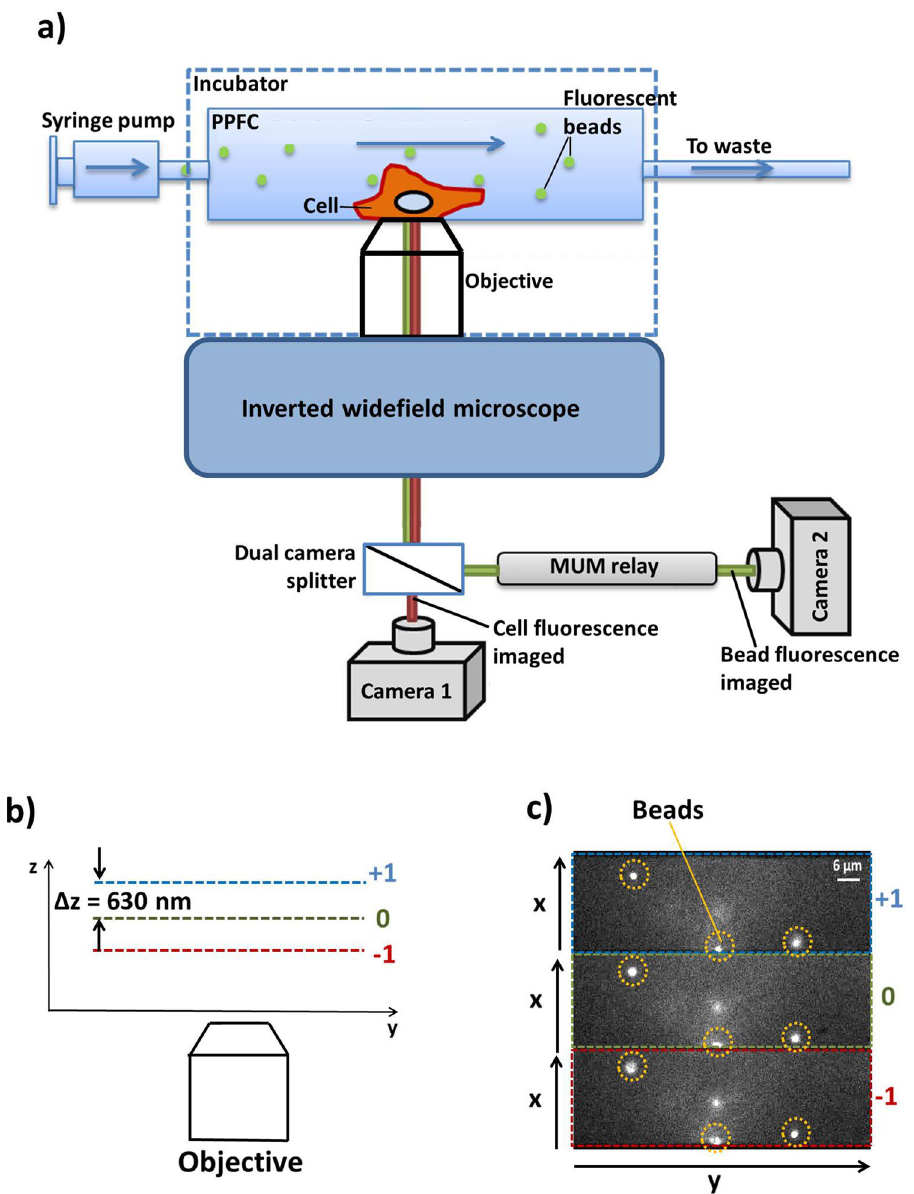
Figure 1. ( a ) Schematic representation of the MUM setup used to perform µPIV. The dual camera splitter and Camera 1 were added only for the live cell experiment. ( b ) Not-to-scale schematic of the axial position of the three planes acquired simultaneously with the MUM setup. ( c ) Example camera image showing beads acquired with the MUM setup. The three different planes imaged simultaneously are